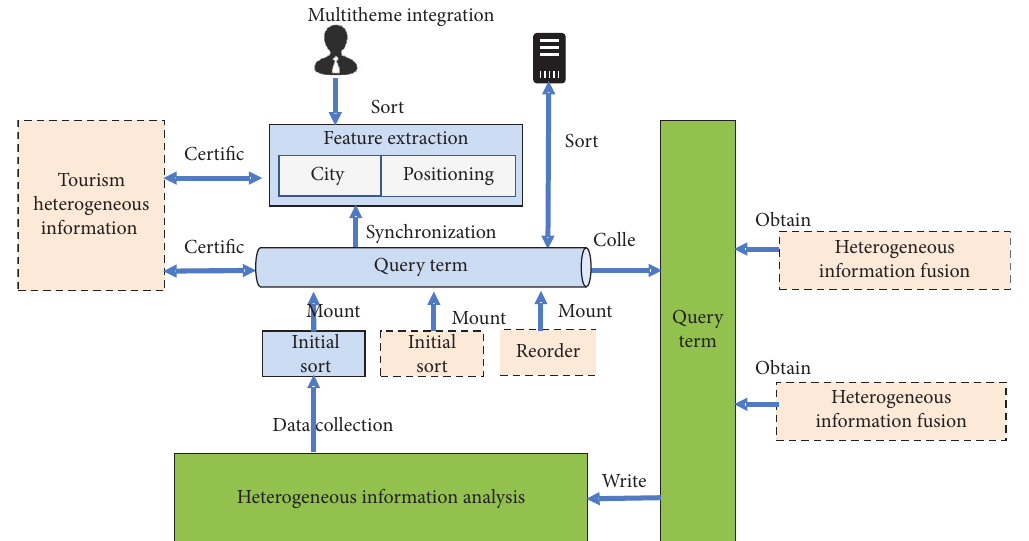
Figure 5: Reordering block diagram of tourist attractions based on heterogeneous information fusion.